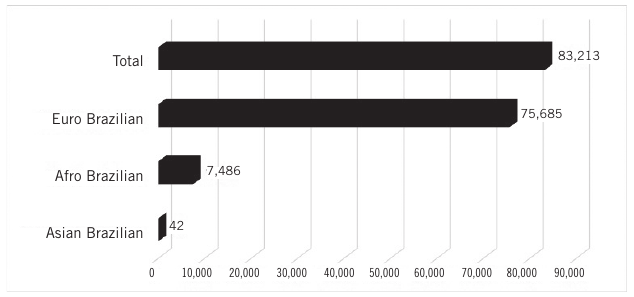
figuRE 1 − Distribution graph of blood donors according to ethnic group